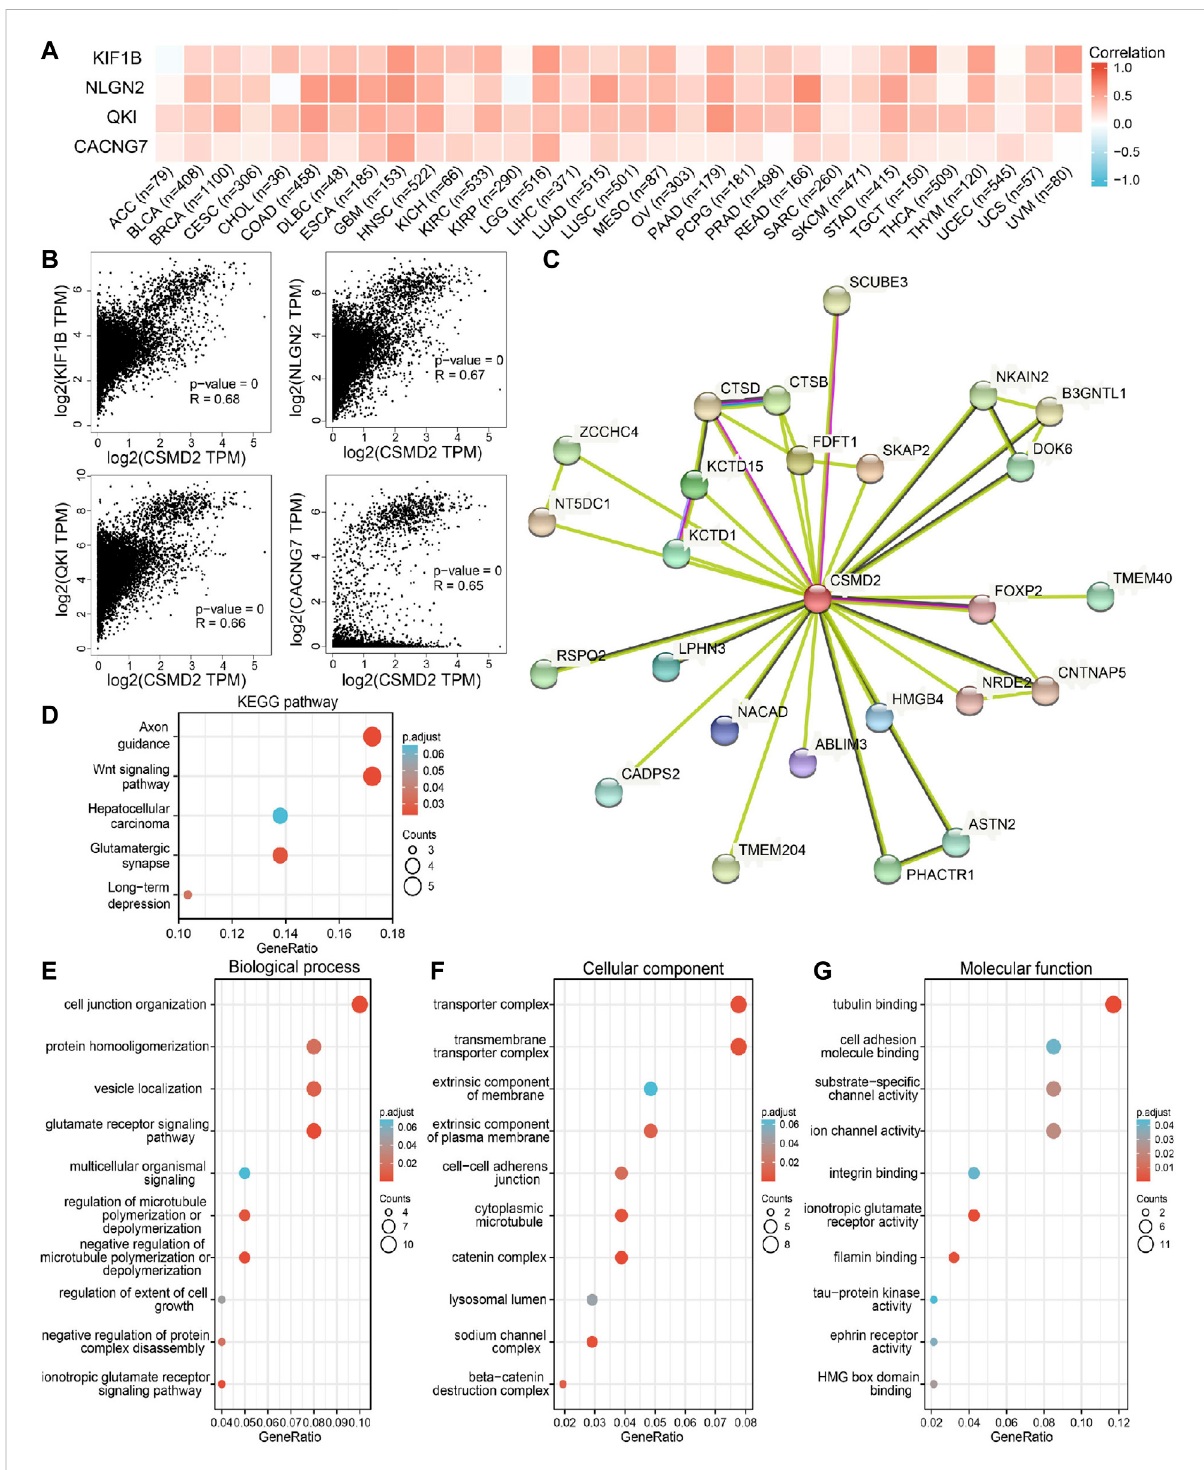
FIGURE 9 CSMD2-relatedgenes,interactingproteinsandfunctionalenrichmentanalysis. (A) and (B) showedthecorrelationbetweenCSMD2andthetop four genes related to it in 33 cancers. (C) The PPI network of CSMD2. GO analyses, including (D) KEGG pathway, (E) biological process, (F) cellular component, and (G) molecular